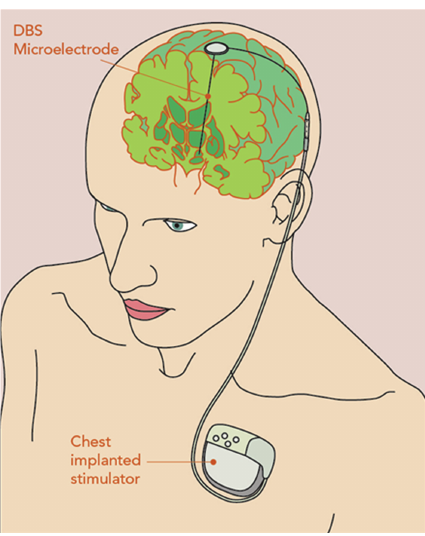
Figure 1: This shows a deep brain stimulator system with the implanted microelectrode; the microelectrode is connected to a programmable stimulator; the stimulator is most often implanted in the subclavicular space.